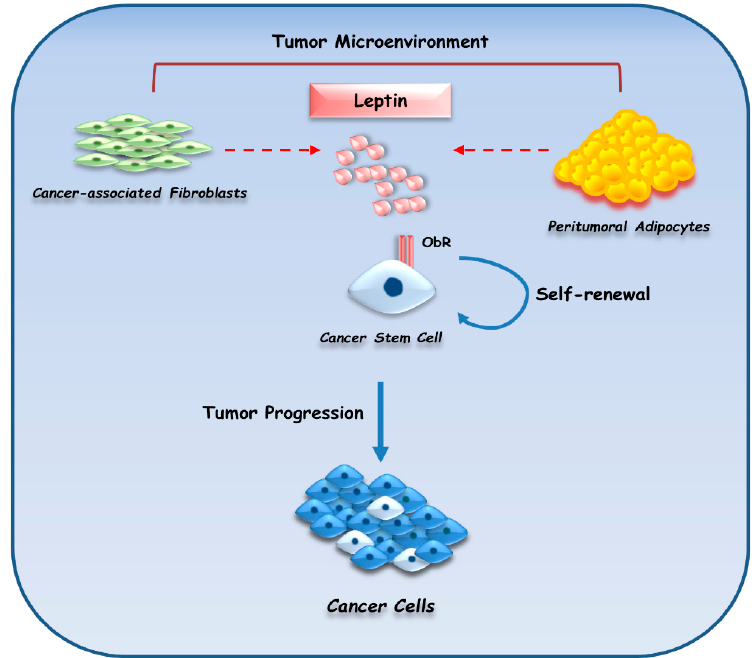
Figure 3. Role of leptin in mediating the interaction between stromal cells and breast cancer stem cells. Leptin, an important paracrine molecule secreted by adipocytes and cancer-associated fibroblasts within the tumor microenvironment, sustains breast cancer stem cell activity, indicating an additional mechanism by which this adipokine promotes breast malignancy.